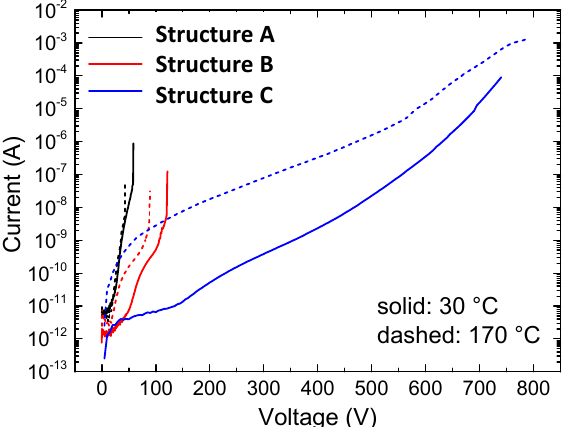
Figure 5. Current–voltage characteristics carried out at both low and high temperatures in the three structures under analysis.